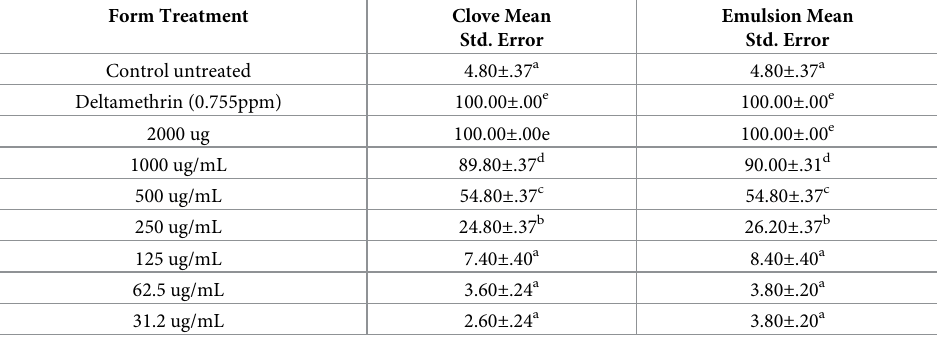
Superscript of the same letter in cells of the same column shows a non-significant effect in respect to the non-treated control. Superscript of different letters in cells of the same column shows a significant effect in respect to the non- treated control ( P �